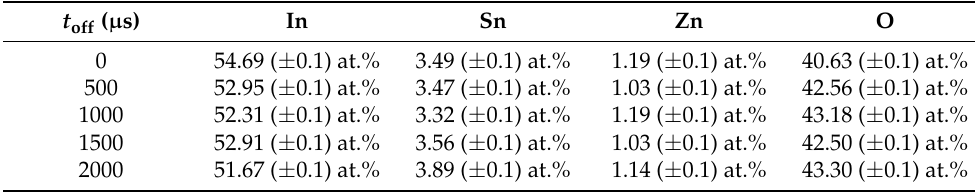
Table 3. Atomic concentration of ITZO films deposited at different pulse off-times.